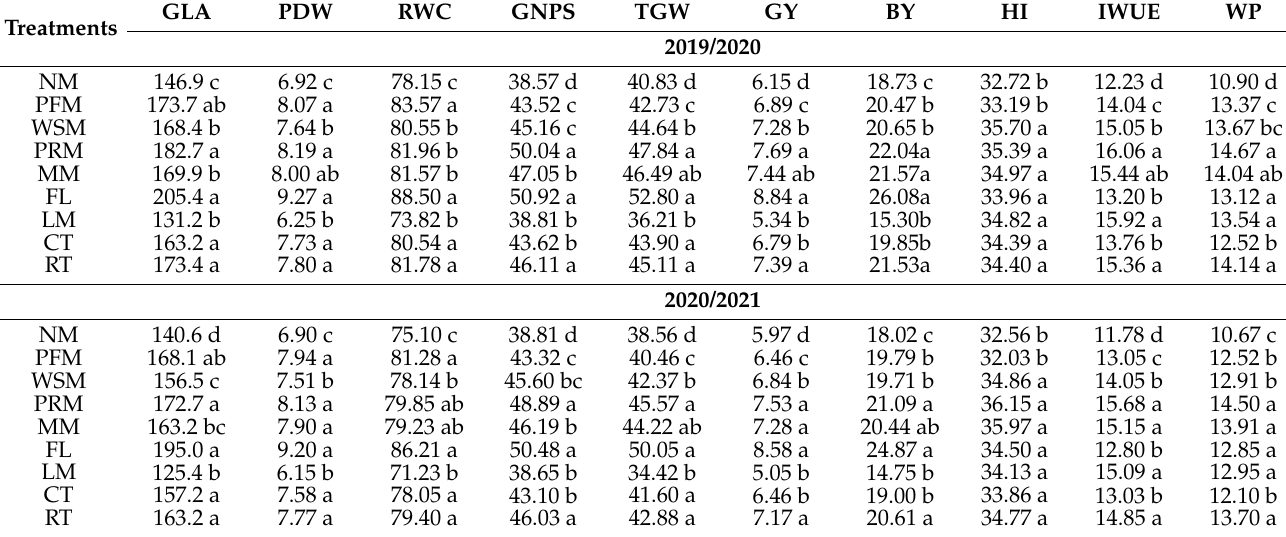
Table 3. Impacts of tillage, irrigation, and mulching treatments on different plant traits of wheat in two growing seasons.